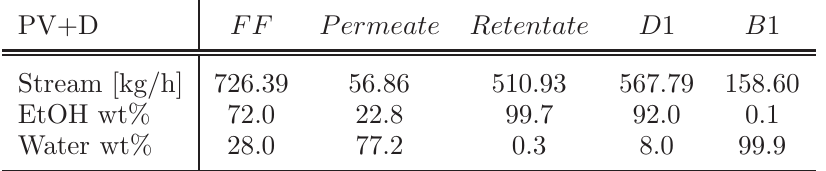
Table 4 Technological streams of isothermal pervaporation,